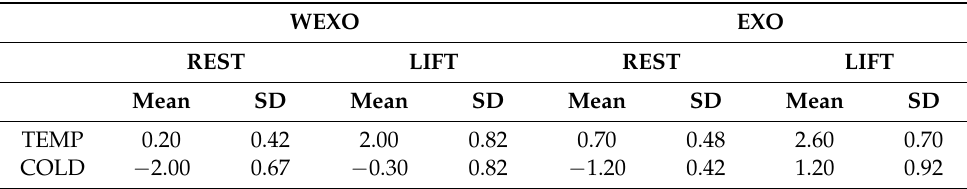
Table A3. Mean (SD) values of thermal sensation vote during the experimental sessions. WEXO